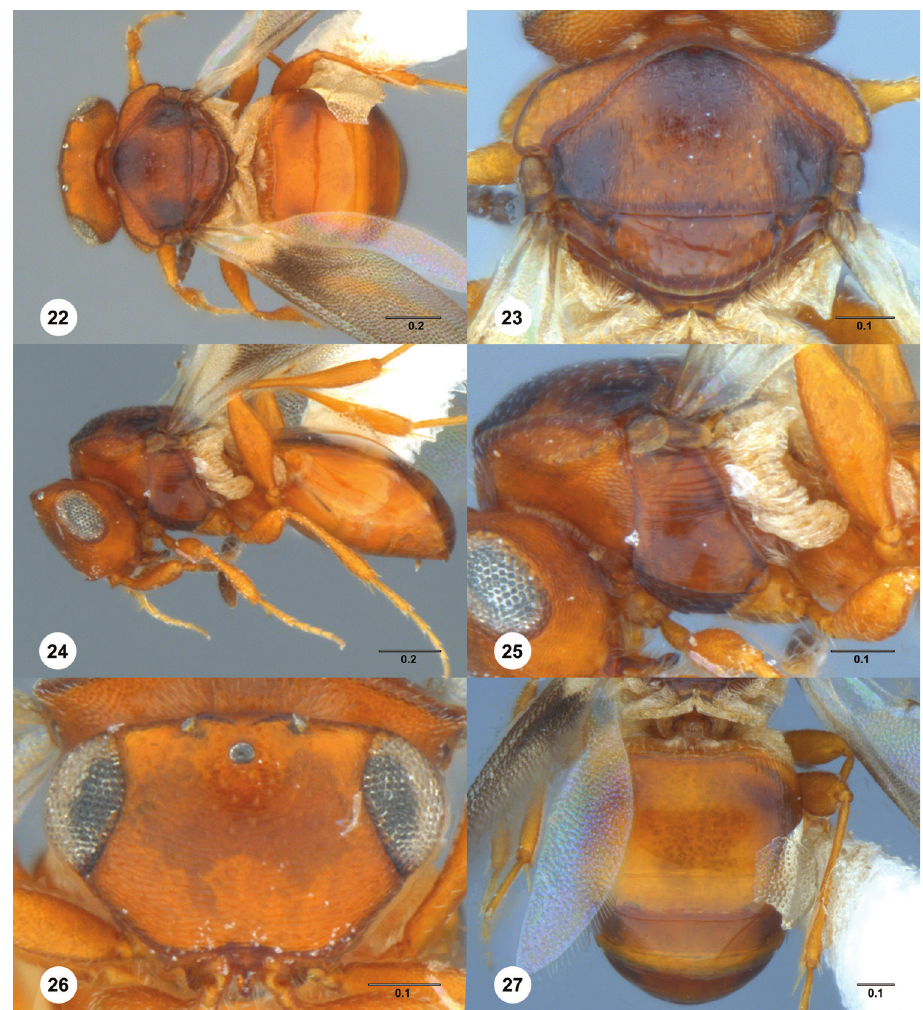
Figures 22–27. Pulchrisolia ellieae , female holotype (OSUC 666430) 22 head, mesosoma, metasoma, dorsal view 23 mesosoma, dorsal view 24 head, mesosoma, metasoma, lateral view 25 mesosoma, lateral view 26 head, anterior view 27 metasoma, dorsal view. Scale bars in millimeters. tween lateral ocelli. Frontal ledge: present. Preocellar depressions: present. Setation of pronotal cervical sulcus: present. Setation of cervical pronotal area: present. Sculpture of pronotal shoulders: reticulate. Sculpture of anterior margin of pronotal shoulders: carinate. Posterolateral margin of pronotal shoulders: sharply angled. Posterior mar- gin of pronotal shoulders: rounded. Antero-admedian line: absent. Anterior admedian depression or pit: present. Parapsidial line: present. Median mesoscutal line: present; indicated posteriorly. Notaulus: absent. Coloration of mesoscutum: darker anterome- dially and posterolaterally. Shape of mesoscutum in lateral view: flat to slightly